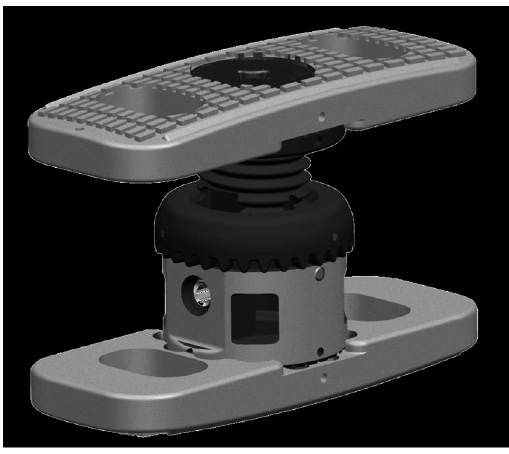
Figure 2. Spine tester (Schunk FT Delta SI 660-60, Lauffen/Neckar, Germany) with six degrees of freedom; three in translation (green) and three in rotation (orange). Specimen embedded in PMMA.